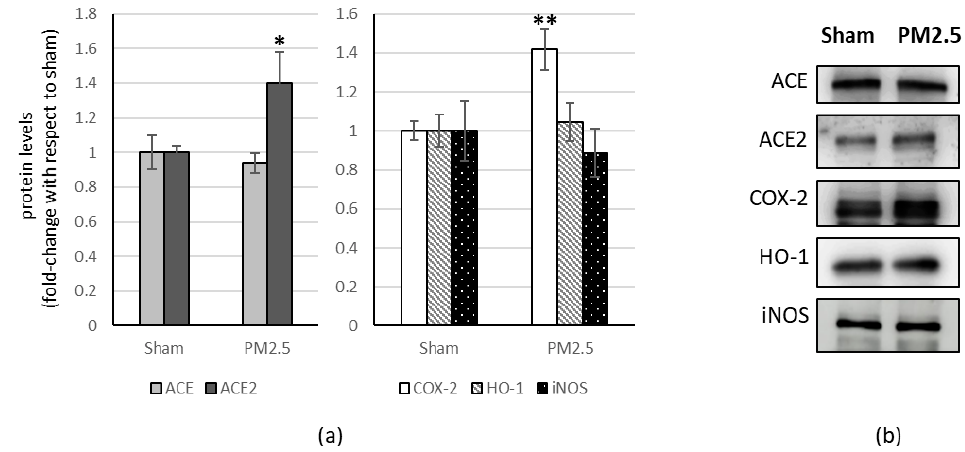
Figure 2. Immunoblotting analysis of ACE, ACE2, and COX-2, HO-1, iNOS in the lung. ( a ) Proteins were evaluated following cell subacute treatment with PM2.5 and have been normalized with re- spect to the total amount of proteins detected by Ponceau staining, allowing a straightforward cor- rection for lane-to-lane variation. Each protein has been normalized onto the respective sham (n = 5). Values represent Mean ± SE. * p < 0.05 versus sham, ** p < 0.01 versus sham ( b ) Corresponding representative immuno-blotting images.